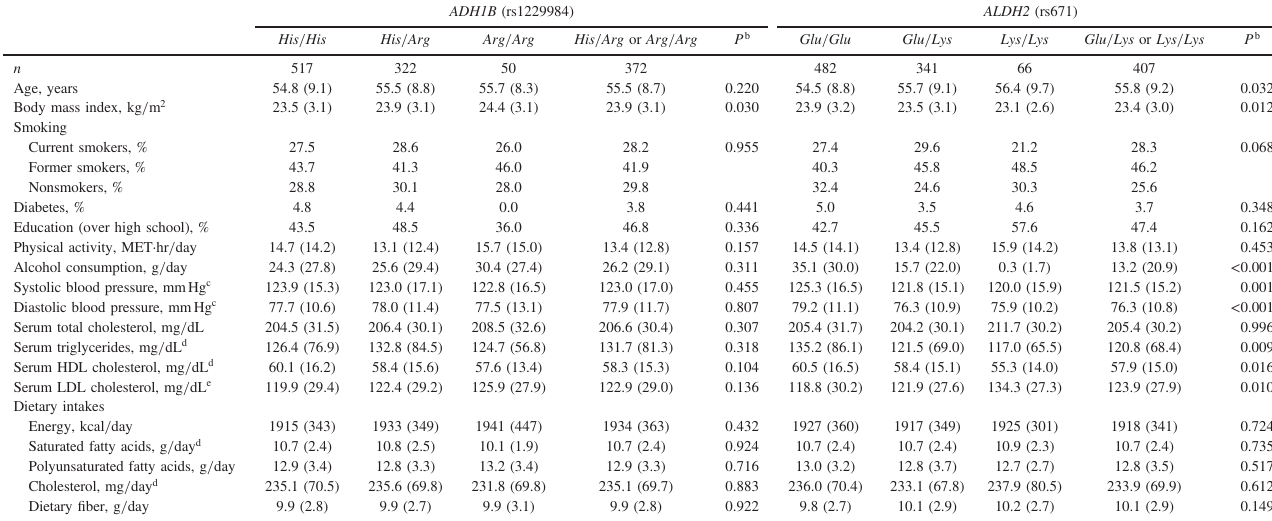
ADH1B (rs1229984) ALDH2 (rs671)